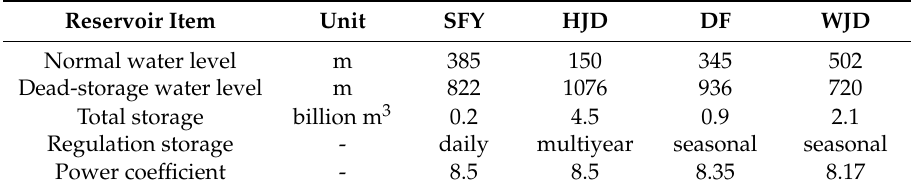
Table 1. Futures of the multireservoir system.